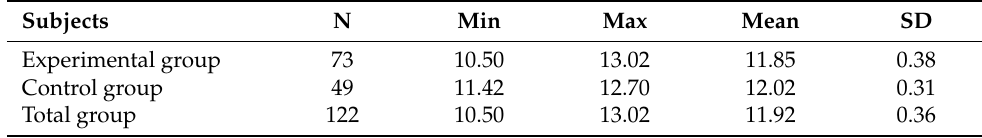
Table 1. Descriptive statistics of study